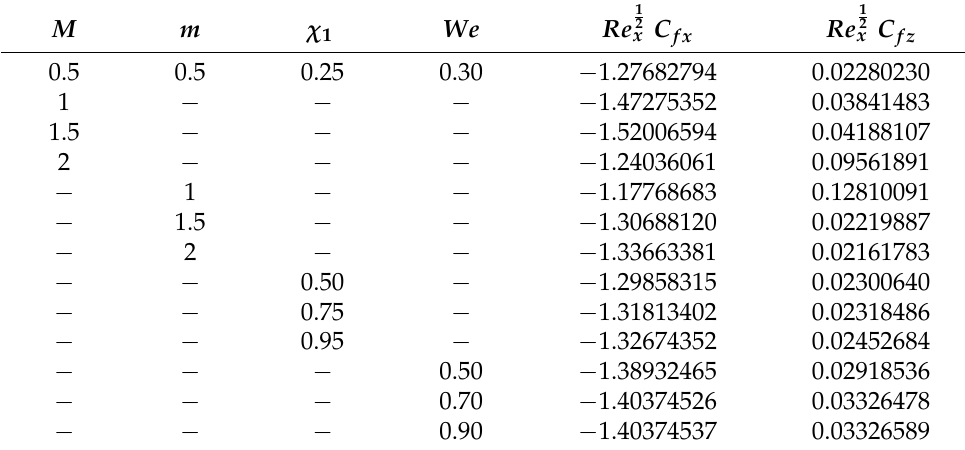
Table 4. Computation of C fx and C fz in the suction